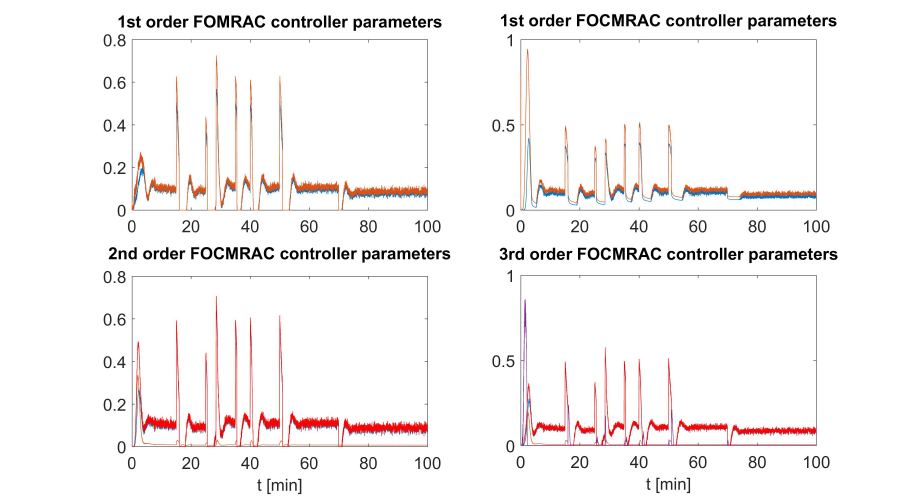
Figure 19. Controller parameters of the adaptive schemes under disturbances and noisy measuremens.